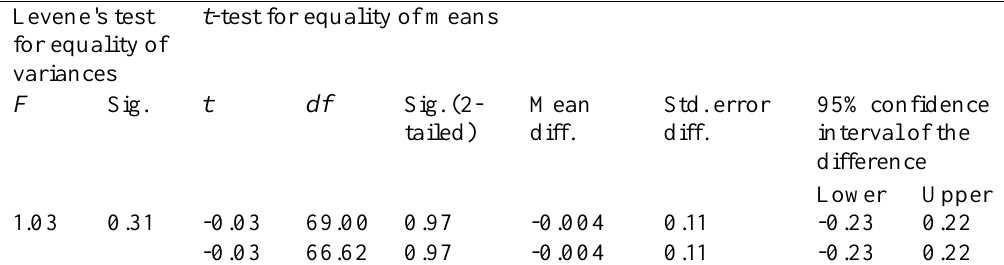
T-Test for Difference in Mean Evaluation Scores between Teaching Staff Age Groups, Received from Students Participating in the Online Distance Learning Program Levene's test for equality of